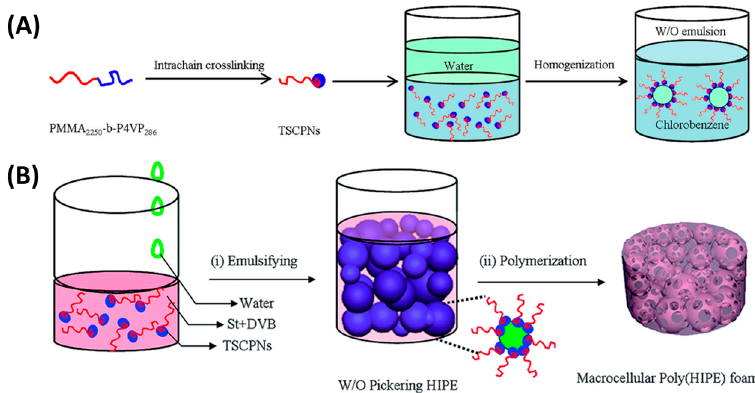
Figure 15. ( A ) Water in Chlorobenzene W/O Emulsions Stabilized by tadpole-like single chain